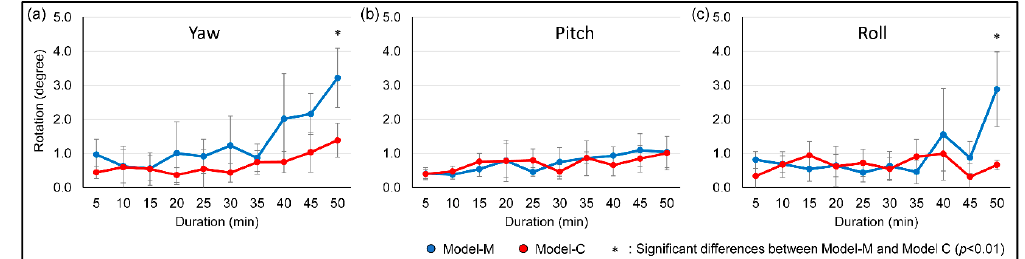
Figure 7. Average amount of rotation. ( a ) yaw, ( b ) pitch, ( c ) roll.